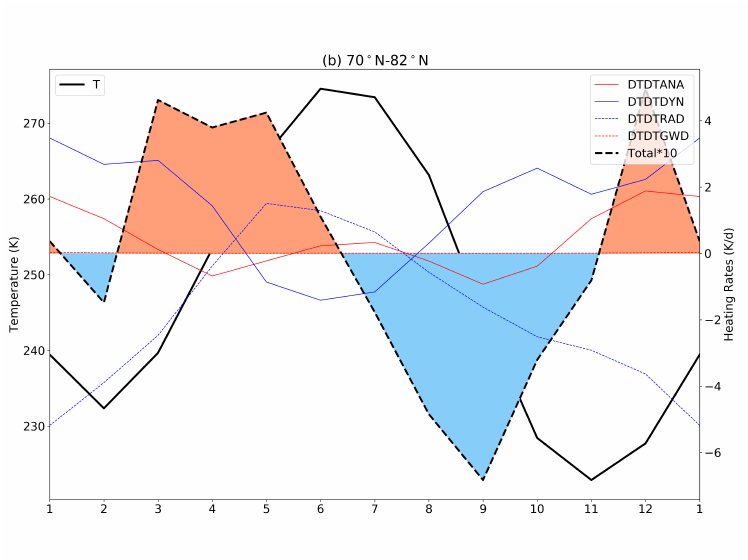
Figure 5. Annual cycle of the zonal mean temperature and heating rates at 2 hPa averaged around the tropical region (10 ◦ S–10 ◦ N) ( a ) and NH high latitudes (70 ◦ N–82 ◦ N) ( b ) based on MERRA2 data. The red, blue, dashed blue and dashed red lines indicate the heating rates related to analysis tendency (DTDTANA), dynamics (DTDTDYN), radiation (DTDTRAD) and gravity wave drag (DTDTGWD), respectively. The positive total heating rates are filled with orange color and the negative total heating rates with blue color. The total heating rates, which are the sum of analysis, dynamical, radiative and GWD heating rates, have been enlarged 10 times to be more visible in the figures.